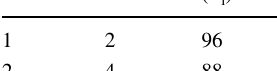
X 2 ). b 3D surface plot of response (